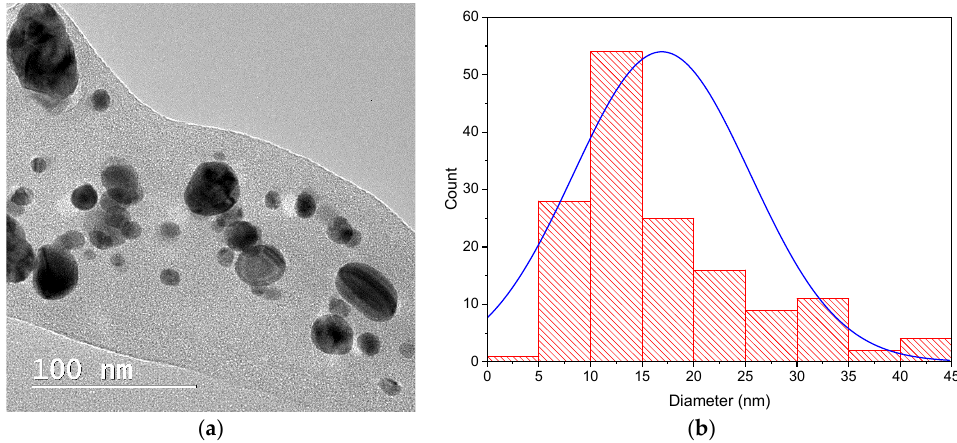
Figure 2. TEM image ( a ) and size distribution ( b ) of the dispersed components in the hydroalcoholic extract of D. filix-mas containing phytosynthesized silver nanoparticles.